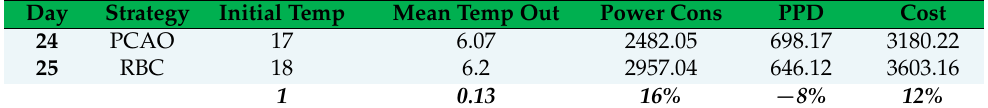
Table 13. Comparison between the PCAO (24th) and RBC (25th) winter days.